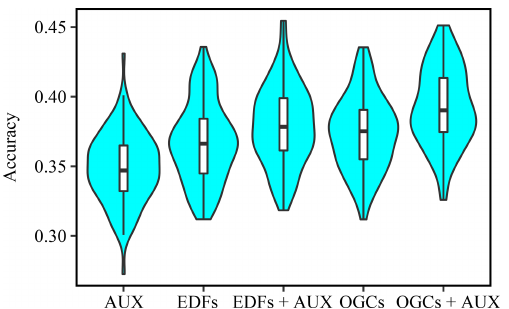
Figure A4. Violin plot showing the accuracies obtained on the eberg dataset (percent correctly predicted) with each method. The plot shows values obtained with 100 splits into training and test datasets.